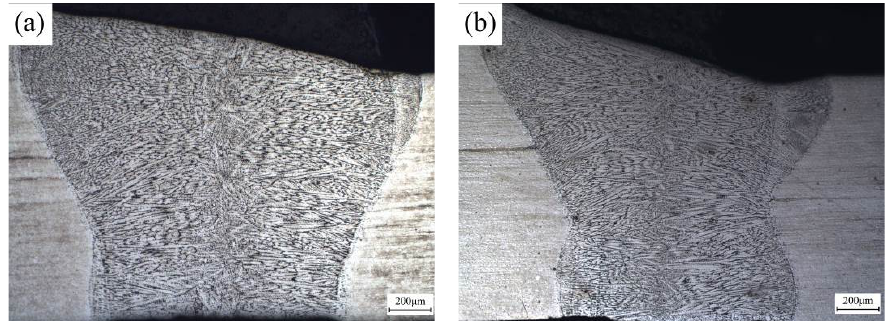
Figure 4. Metallographs of the cross-section of the weld joint under different welding speeds ( a ) 22 mm/s; ( b ) 40 mm/s.